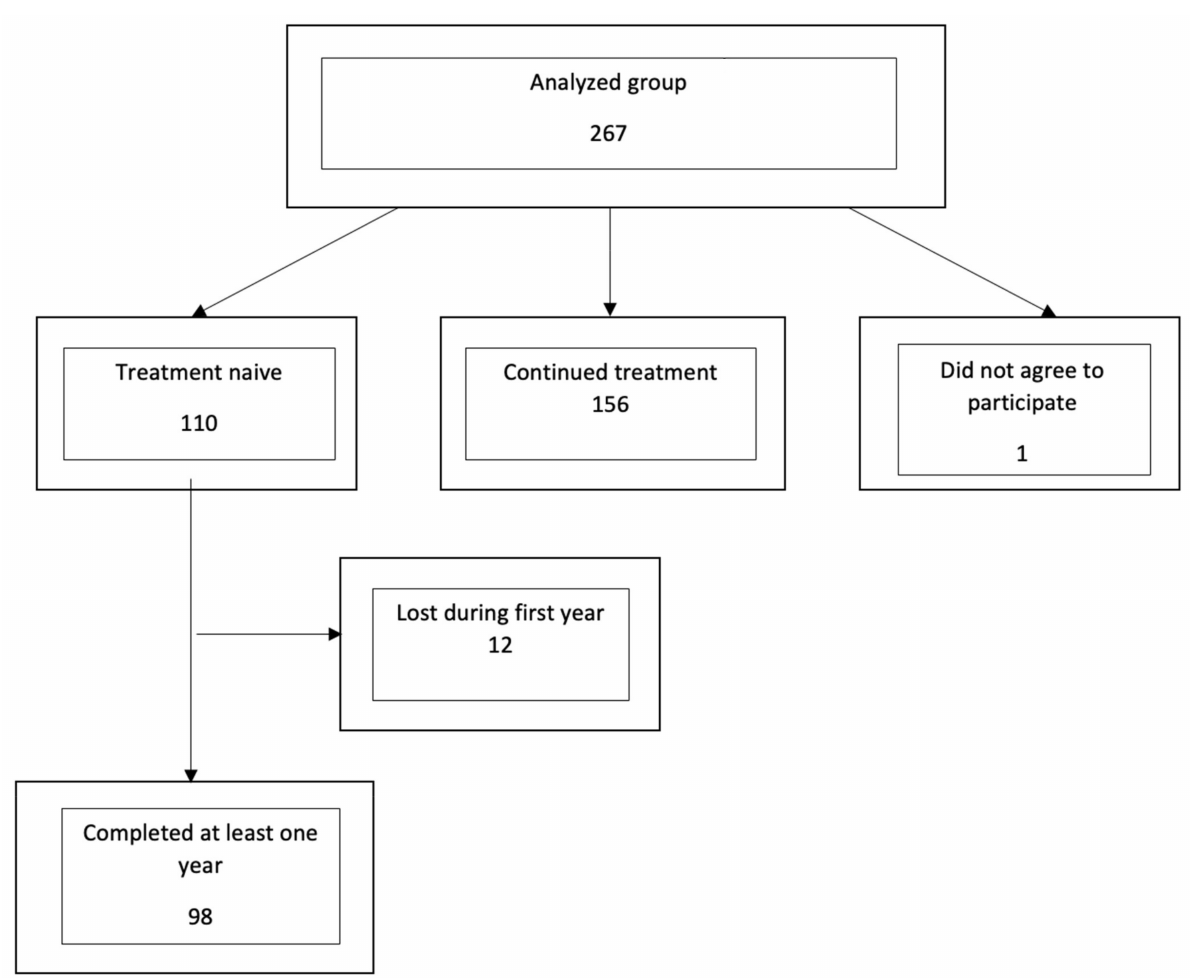
Figure 1. Flowchart for the selection of eyes included in the